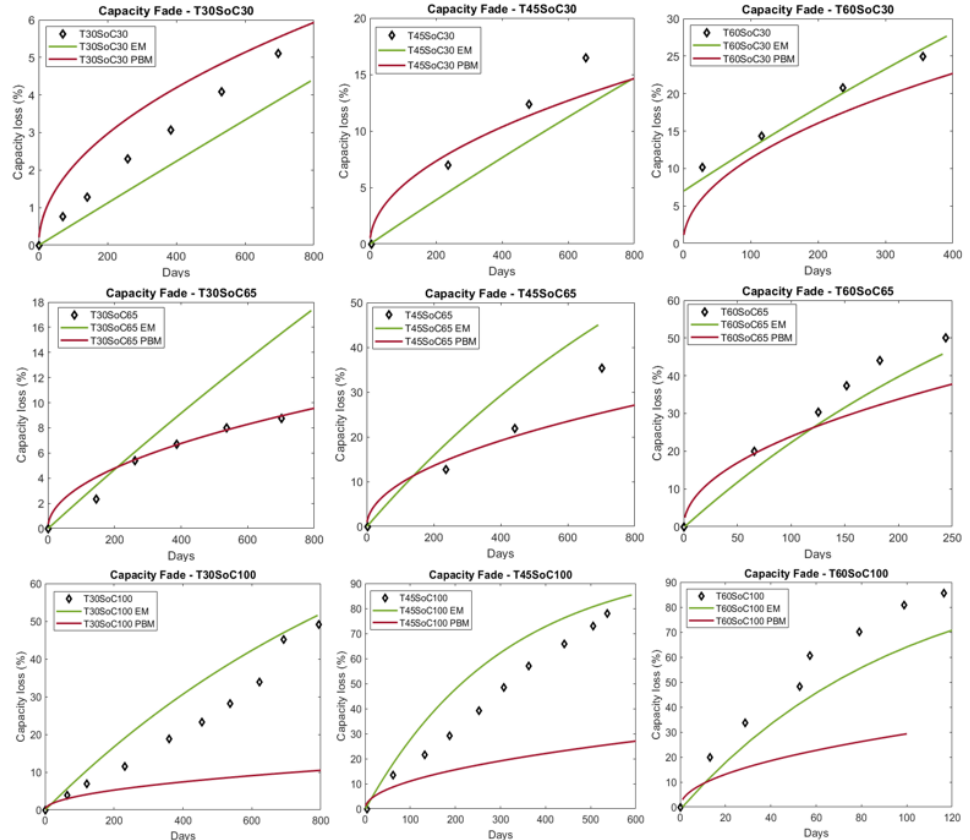
Figure 4. Comparison of capacity fade in calendar aging between aging data for the EM and